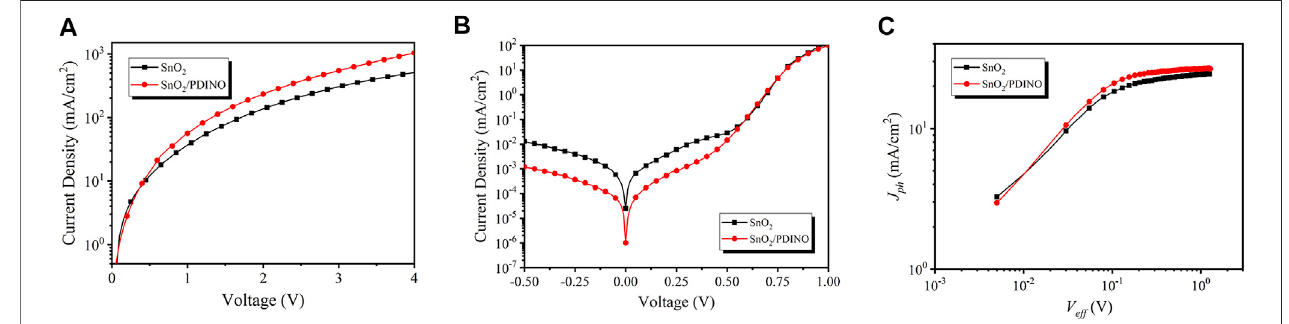
FIGURE 6 | (A) J – V curves of electron-only devices. (B) J – V curves of OSC devices in dark condition. (C) Plots of photocurrent ( J ph ) dependence on effective voltage ( V eff